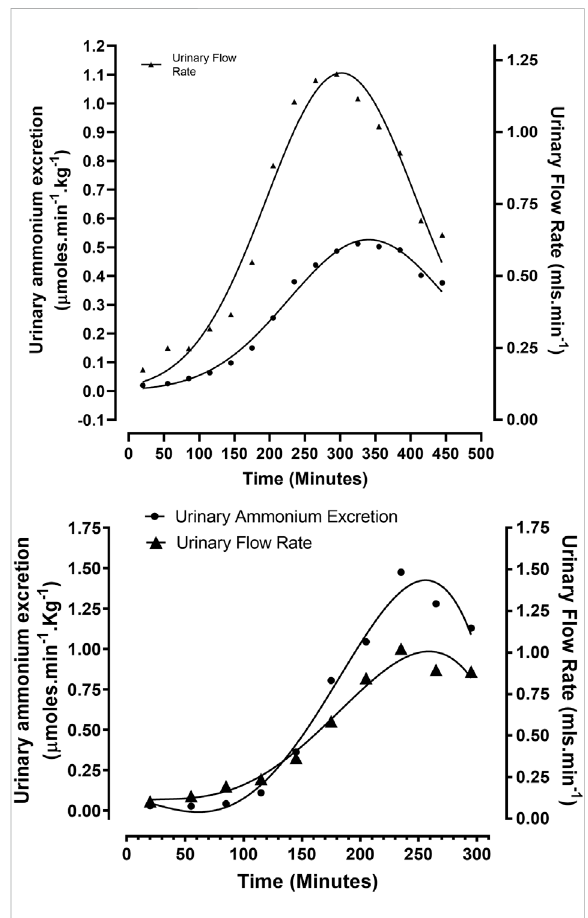
FIGURE 1 Correlation between urinary fl ow and ammonium excretion ratesinrabbitstreatedaccordingtoProtocols2and3: (A) Protocol 2 (N = 5): Ethanolic - dextrose + 0.1 M HCl, non – mechanically ventilated. (B) Protocol 3 (N = 4): Ethanolic - dextrose + 0.1 M HCl, mechanically ventilated.